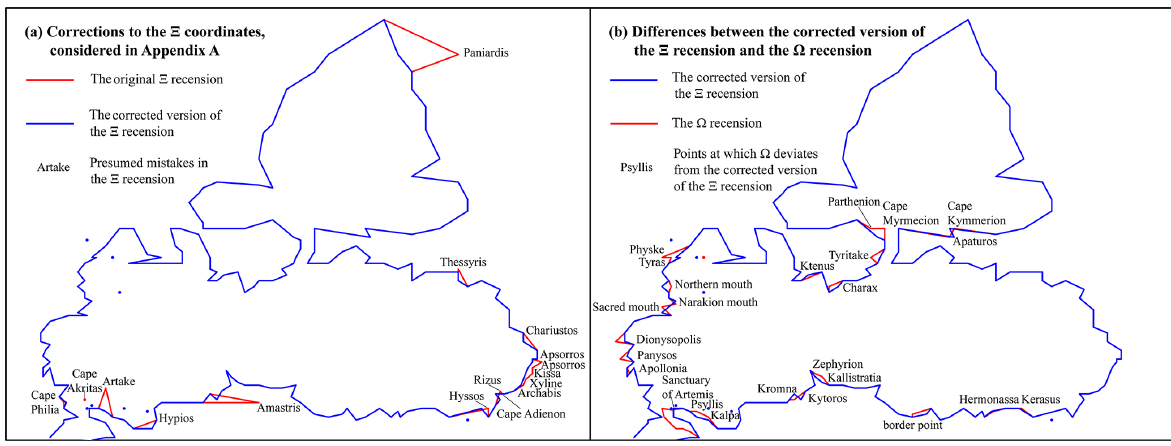
Figure 4. The outlines of the Pontus Euxinus according to the (cid:52) and (cid:127) recensions of Ptolemy’s Geography and a corrected version of the (cid:52)